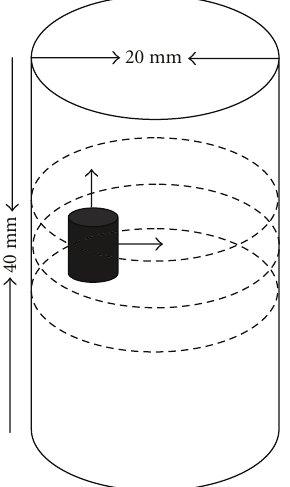
Figure 8: Schematic diagram of the phantom of radius 10mm and height 40 mm with a uniform background of μ axf = 0 . 005mm − 1 , which is positioned at x = 10mm, y = 0mm, and z = 20mm. The small cylindrical anomaly has a radius of 2mm and height 6mm with μ axf = 0 . 01mm − 1 . The anomaly is positioned at x = 5mm, y = 0mm, and z = 20mm. The dashed curves represent the measurement planes, at z = 15mm, z = 20mm, z = 25mm, each containing four sources and sixteen